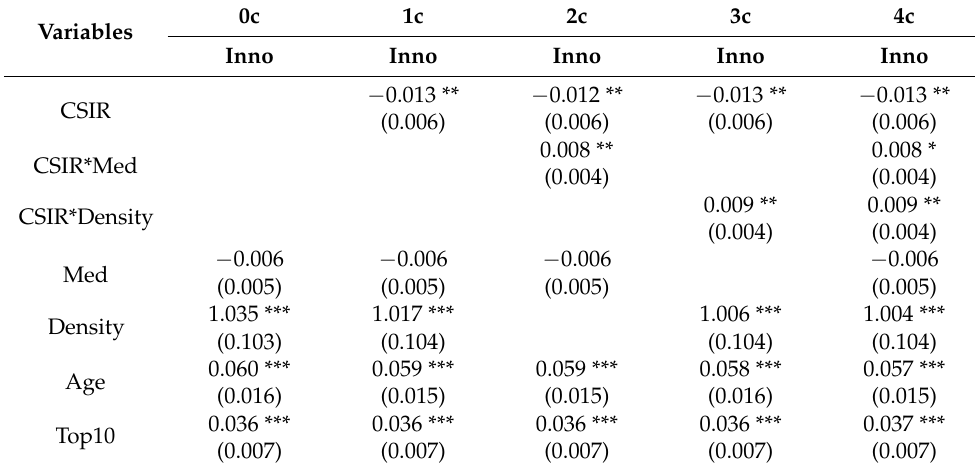
Table 5. CSR risk, social network, and innovation